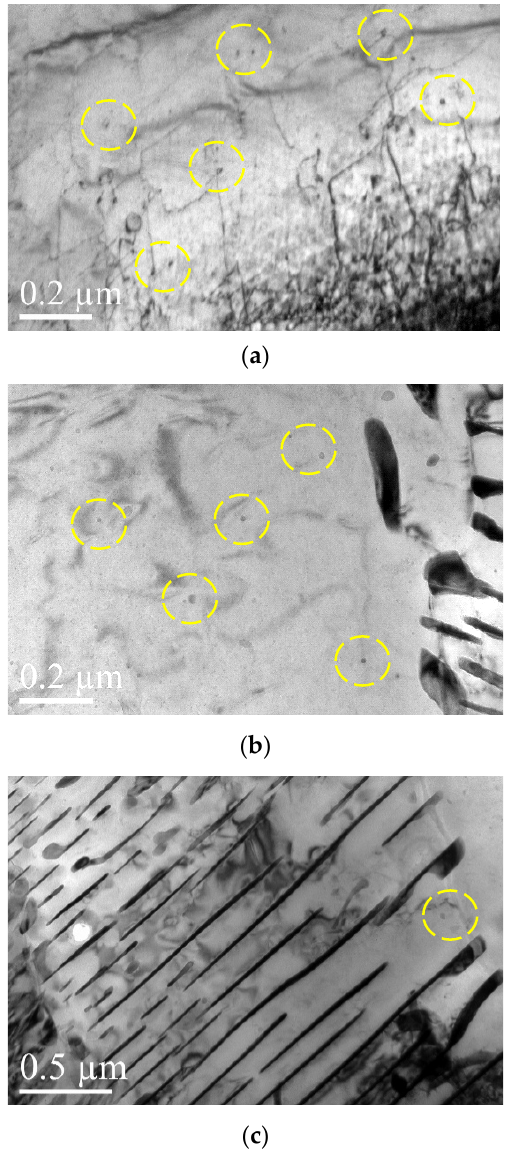
Figure 11. TEM micrographs for J13 that show the precipitates ( a , b ) in the pro-eutectoid ferrite and ( c ) in the pearlite.